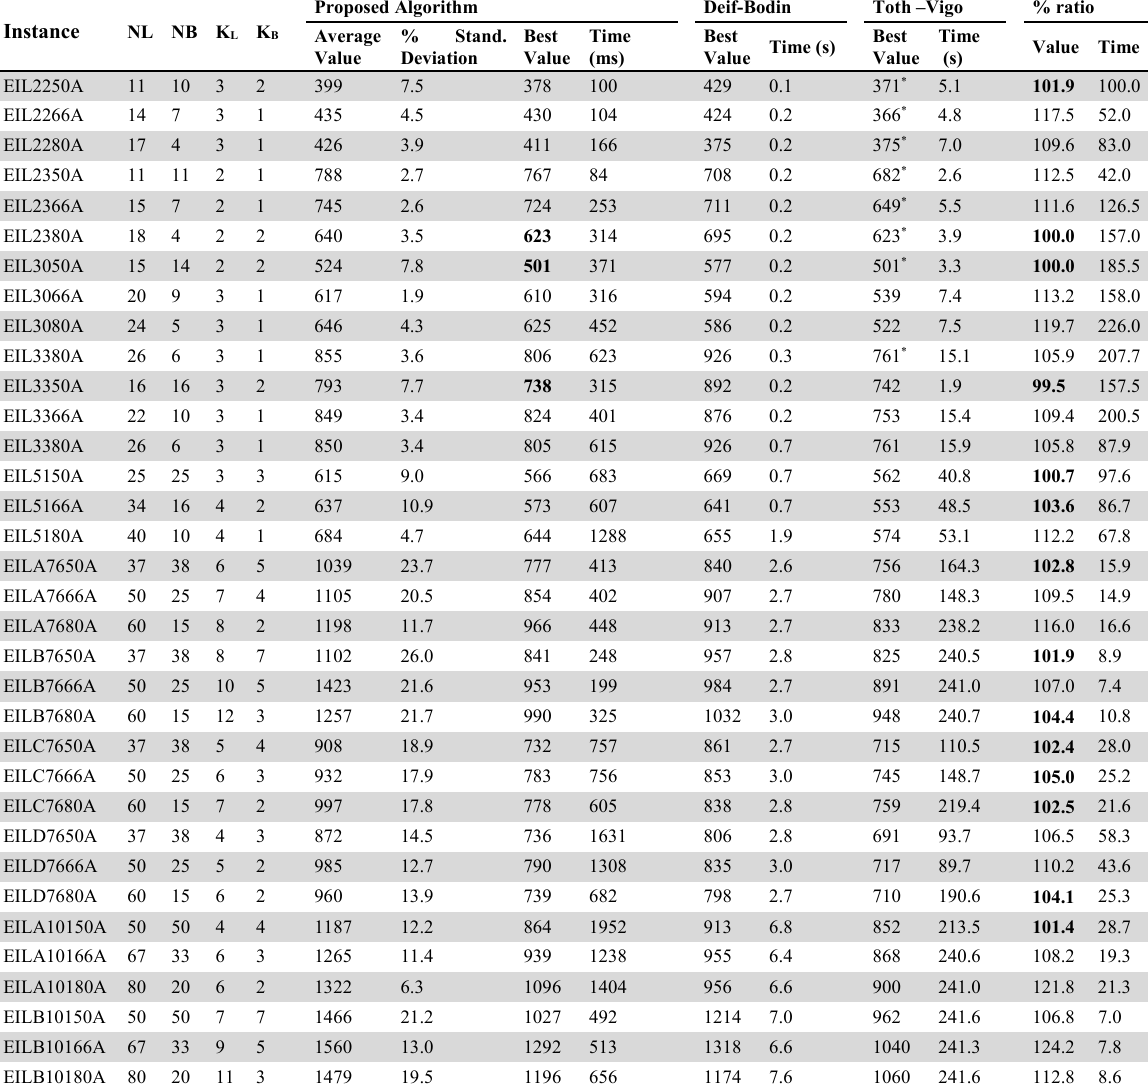
Results found by the proposed algorithm on VRPB Instances Proposed Instance NL NB K L K B